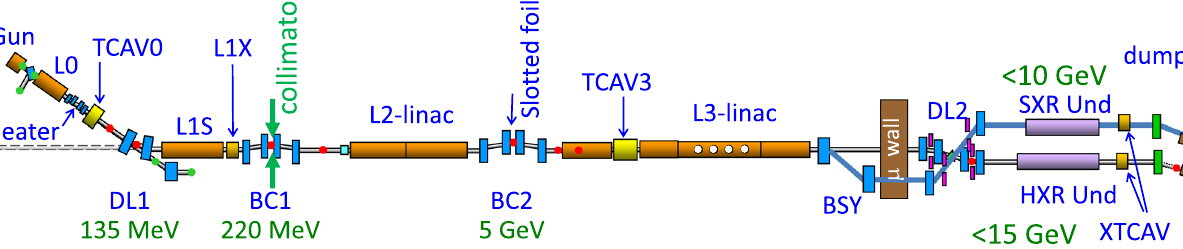
Figure 1. Schematic layout of the LCLS copper linac configuration. Electron bunches are extracted at a normal conducting gun and subsequently accelerated in Linac sections and compressed in the first (BC1) and second (BC2) bunch compressors. A laser heater increases the electrons energy spread to suppress a microbunching instability. X-band linearizer L1X provides longitudinal time-energy electron bunch control for improved bunch compression and reduces phase space nonlinearities. Transverse deflecting cavities (XTCAV) are mainly used for diagnostic purposes 35 . In the beam switchyard (BSY), the electron bunches are directed to either SXR or HXR undulator lines. In the undulator lines, the electron bunches produce x-ray Free-electron laser pulses. Downstream from the undulator, the electrons are discarded after a vertical bend in the beam dumps, while the x-rays are delivered to the experimental